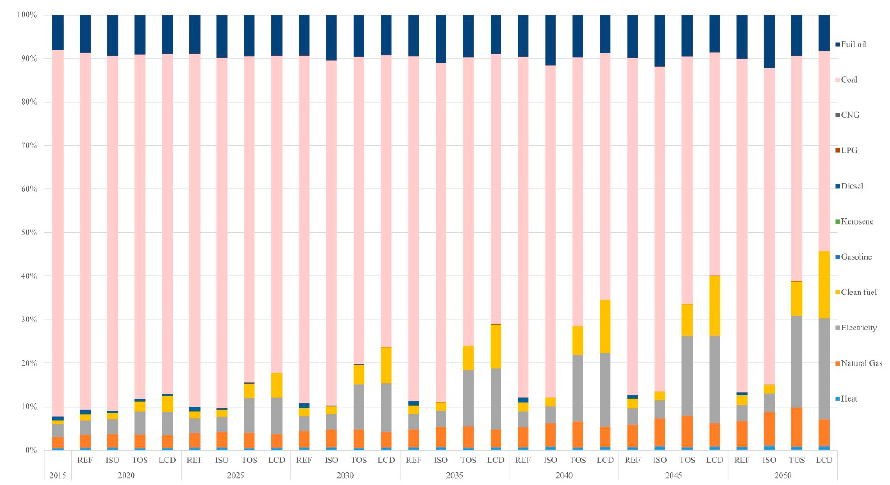
Figure 5. The proportion of final energy use by fuel type.